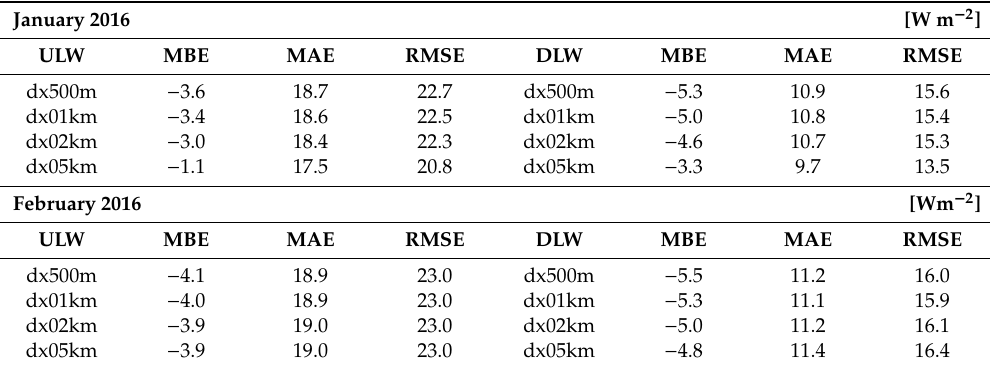
Table 5. Same as Table 4, but for the Exp-Winter season (January (upper tables) and February (lower tables)) in